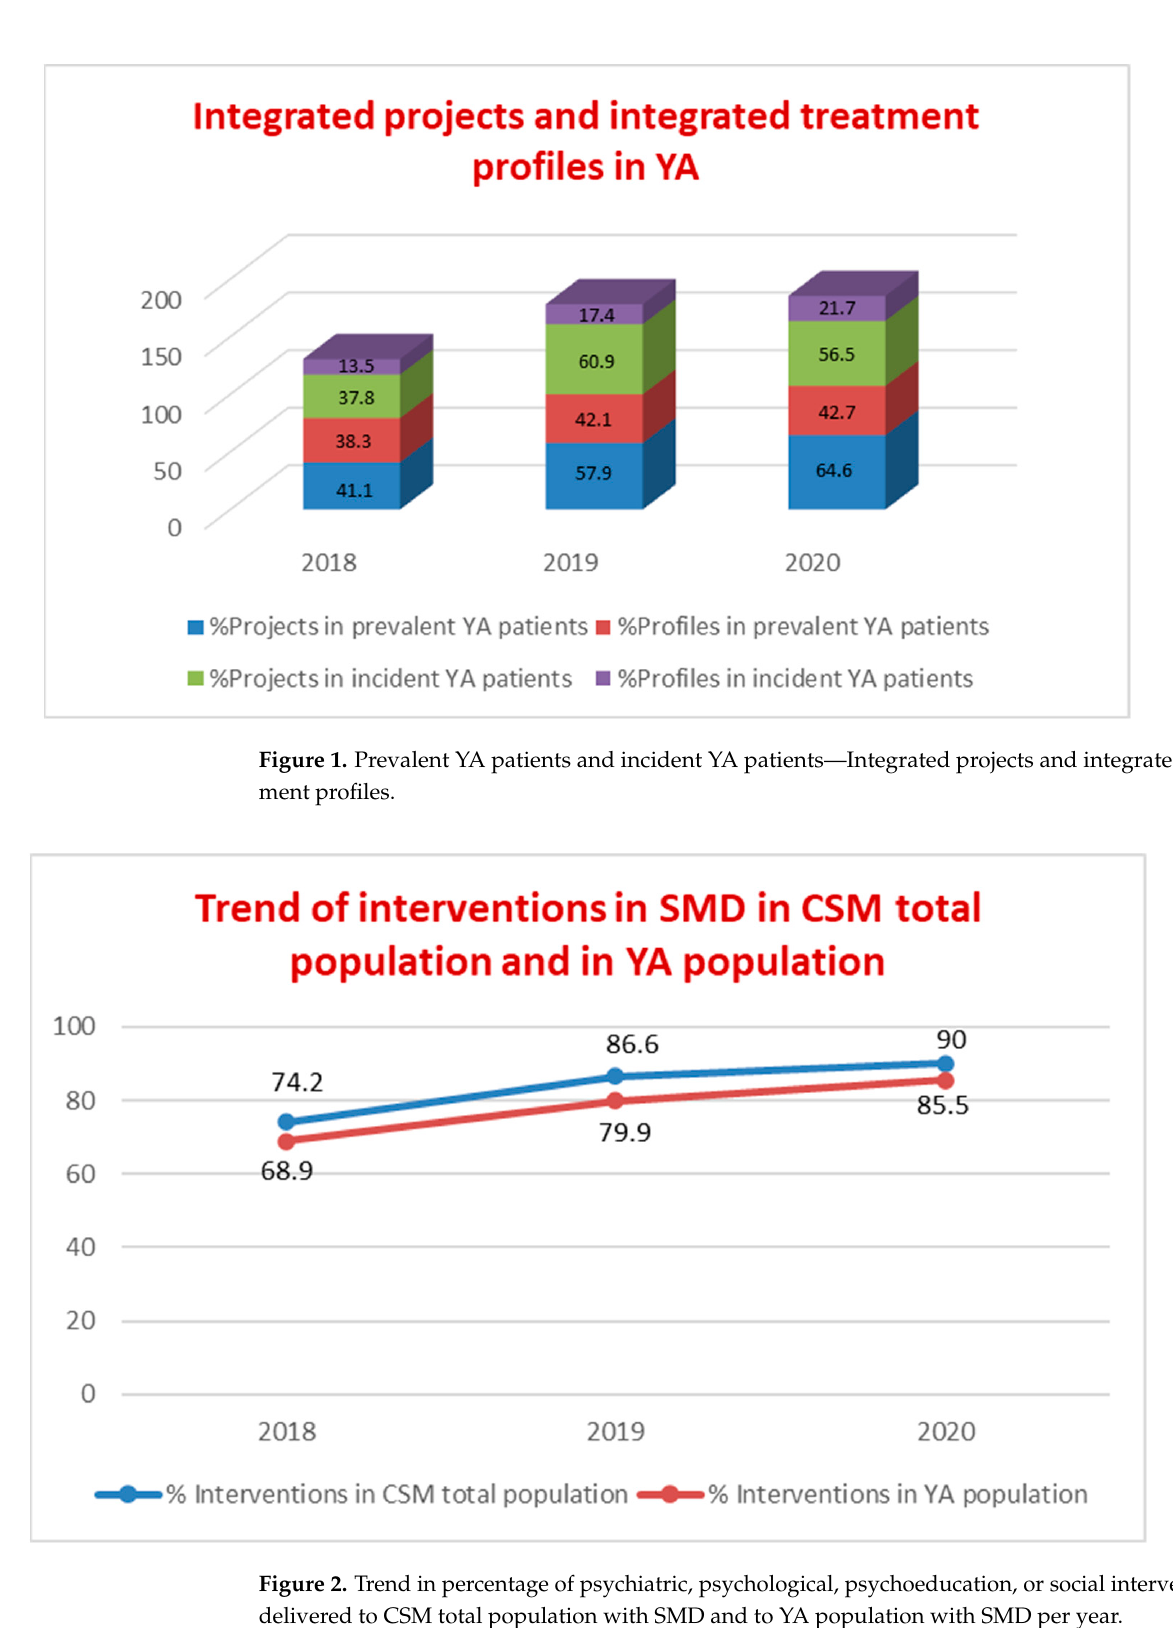
Figure 2. Trend in percentage of psychiatric, psychological, psychoeducation, or social interventions delivered to CSM total population with SMD and to YA population with SMD per year.